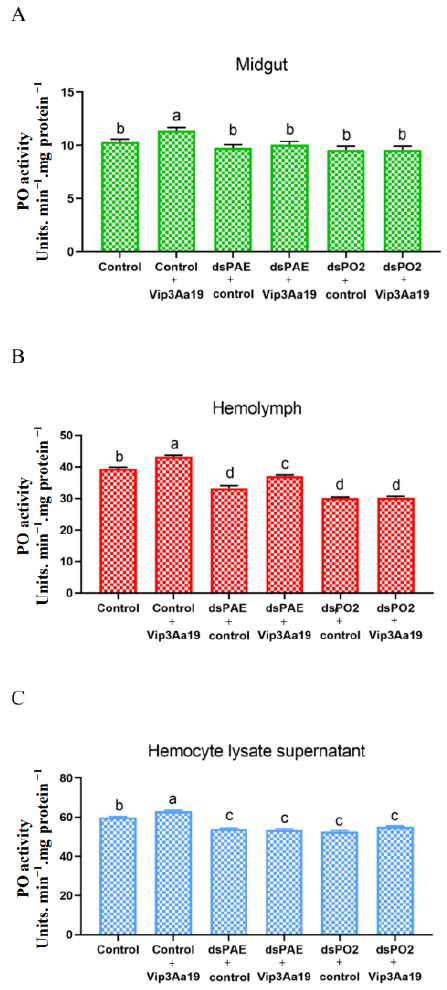
Figure 5. PO activity assessment in the midgut, hemolymph and hemocyte lysate supernatant samples of S. frugiperda. ( A ). PO activity in midgut samples extracted from control and Vip3Aa19 toxin treatment in Sf PAE and Sf PO2 knockdown larvae. ( B ). PO levels in hemocyte-free hemolymph samples collected from control and Vip3Aa19 toxin treatment in Sf PAE and Sf PO2 knockdown larvae. ( C ). PO activity in hemocyte lysate supernatant samples collected from control and Vip3Aa19 toxin treatment in Sf PAE and Sf PO2 knockdown larvae. PO activity was based on six replicates (mean ± SEM). Vertical bars under different letters within the sample tested were statistically significant (Tukey’s, p < 0.05), and the bars with the same letter are insignificant.